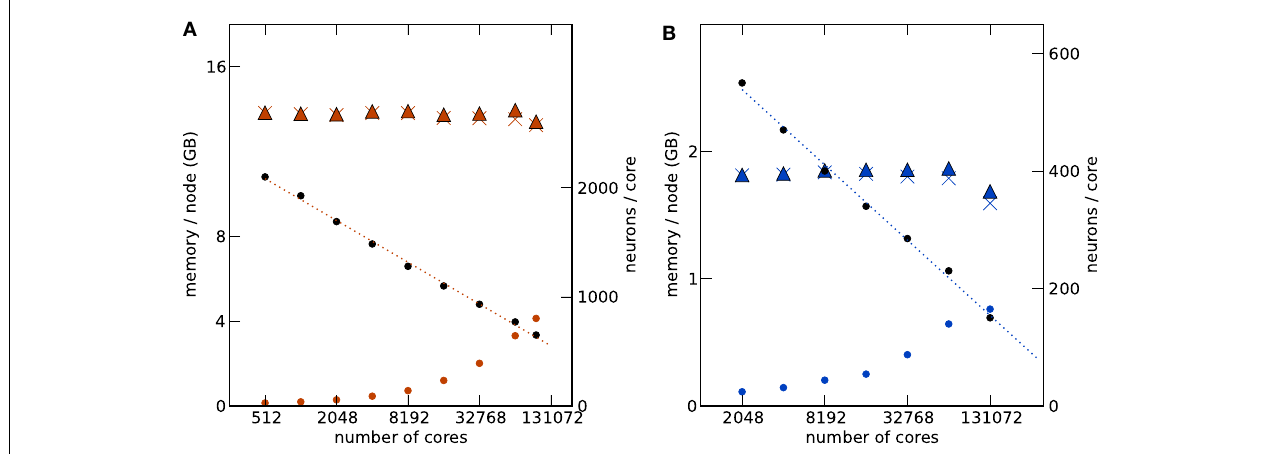
consumption at different stages of the simulation.The largest contribution is due to the synapses. All data are represented using log-linear axes. (A) K computer with 13.85GB (nominal 16GB) memory per compute node. (B) JUGENE computer with 1.84GB (nominal 2GB) memory per compute node. Note that the last point at 131,072 cores is slightly below the maximum memory usage, as the bisectioning method we used to empirically determine the largest possible number of neurons per core did not converge before the end of our access period to K.